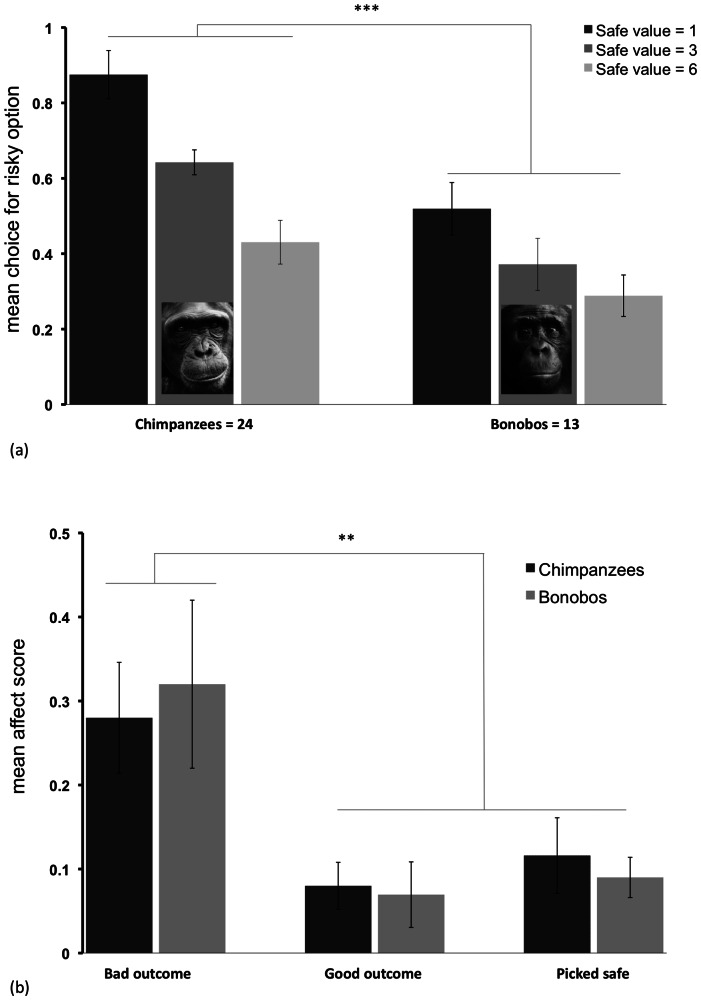
Risk preferences and affective responses in study 2.a) Chimpanzees and bonobos chose between a safe option that provided an intermediately-preferred food and a risky option that provided either a good outcome (highly-preferred food) or a bad outcome (non-preferred food). b) Composite affect scores following different choice outcomes (bad, good, or safe); a higher score indicates a more intense reaction with the production of more target behaviors (scratching, vocalizing, and banging). Error bars represent standard error of means.